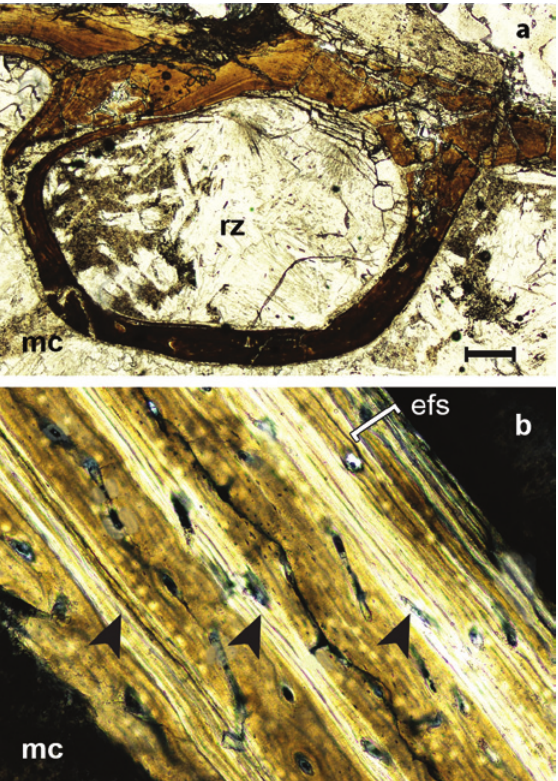
Fig. 11 - Bone microstructure of Tropeognathus cf. T. mesembrinus . (A) Transverse section of the first wing phalanx showing a resorptive cavity in the medullary surface. Scale bar 50 μ . (B) Detail of the wing phalanx section, arrows indicate periodical interruption in growth. See text for abbreviations. Scale bar 100 μ